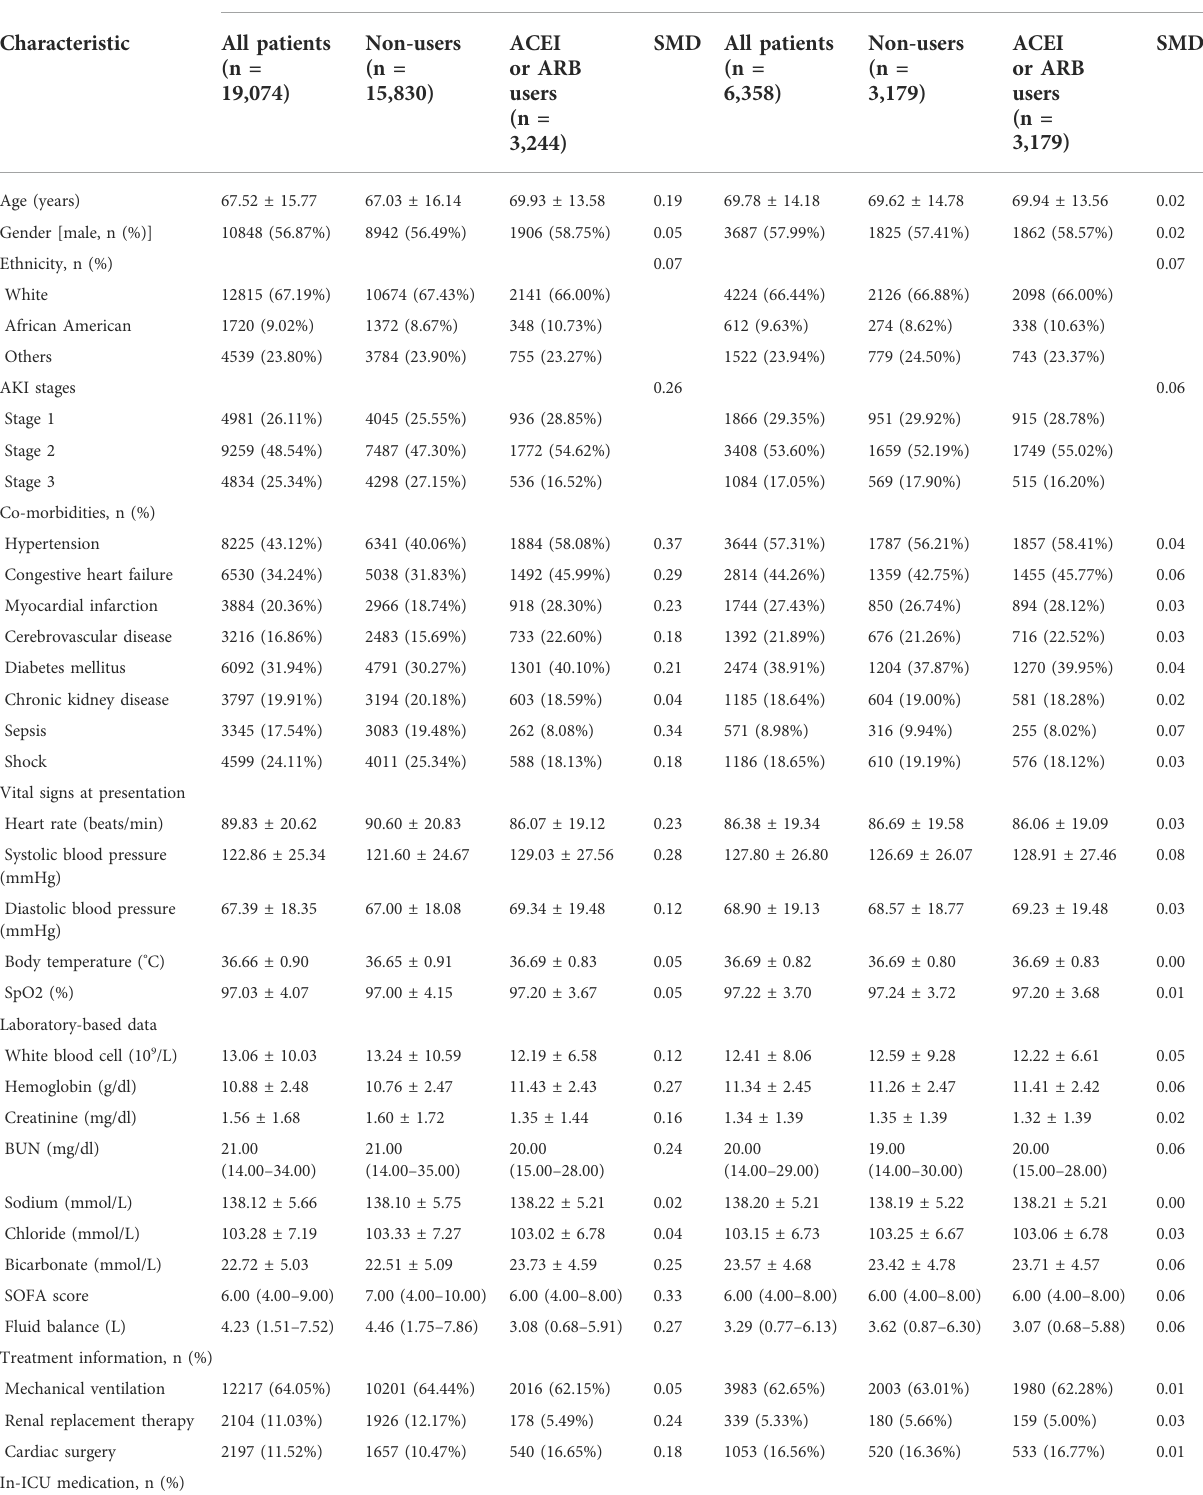
TABLE 1 Baseline characteristics of ACEI/ARB users and non-users. Before PSM After